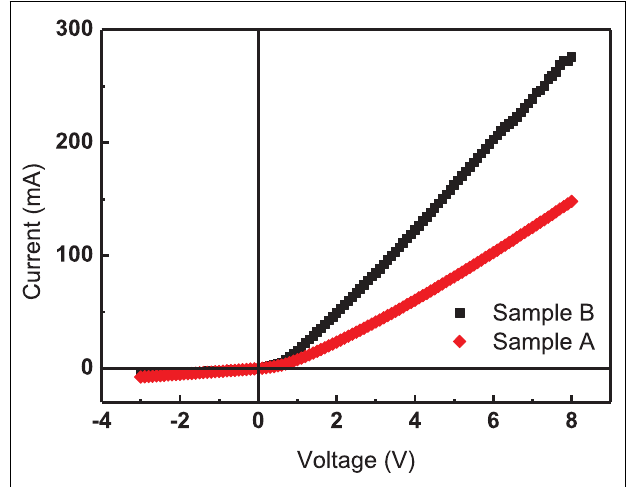
FIGURE 2 | I – V curves of the two pn diodes at room temperature .